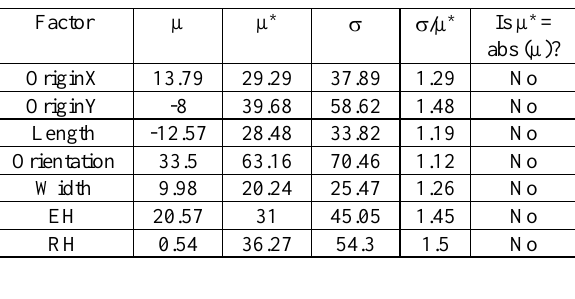
Table 3. Estimated qualitative measures (Gabled roof-type case)